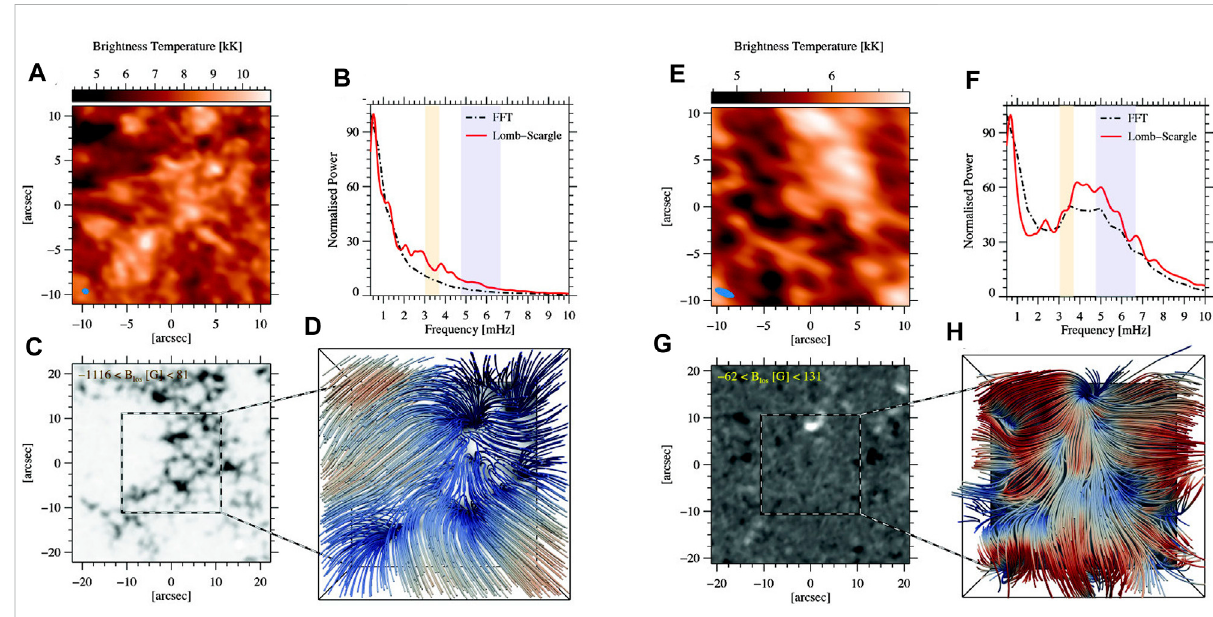
FIGURE 3 Same as Figure 2 but for the 22 April 2017 Band 6 dataset (panels A – D ) and the 12 April 2018 Band 6 dataset (panels E – H ). Figure reproduced from Jafarzadeh et al.